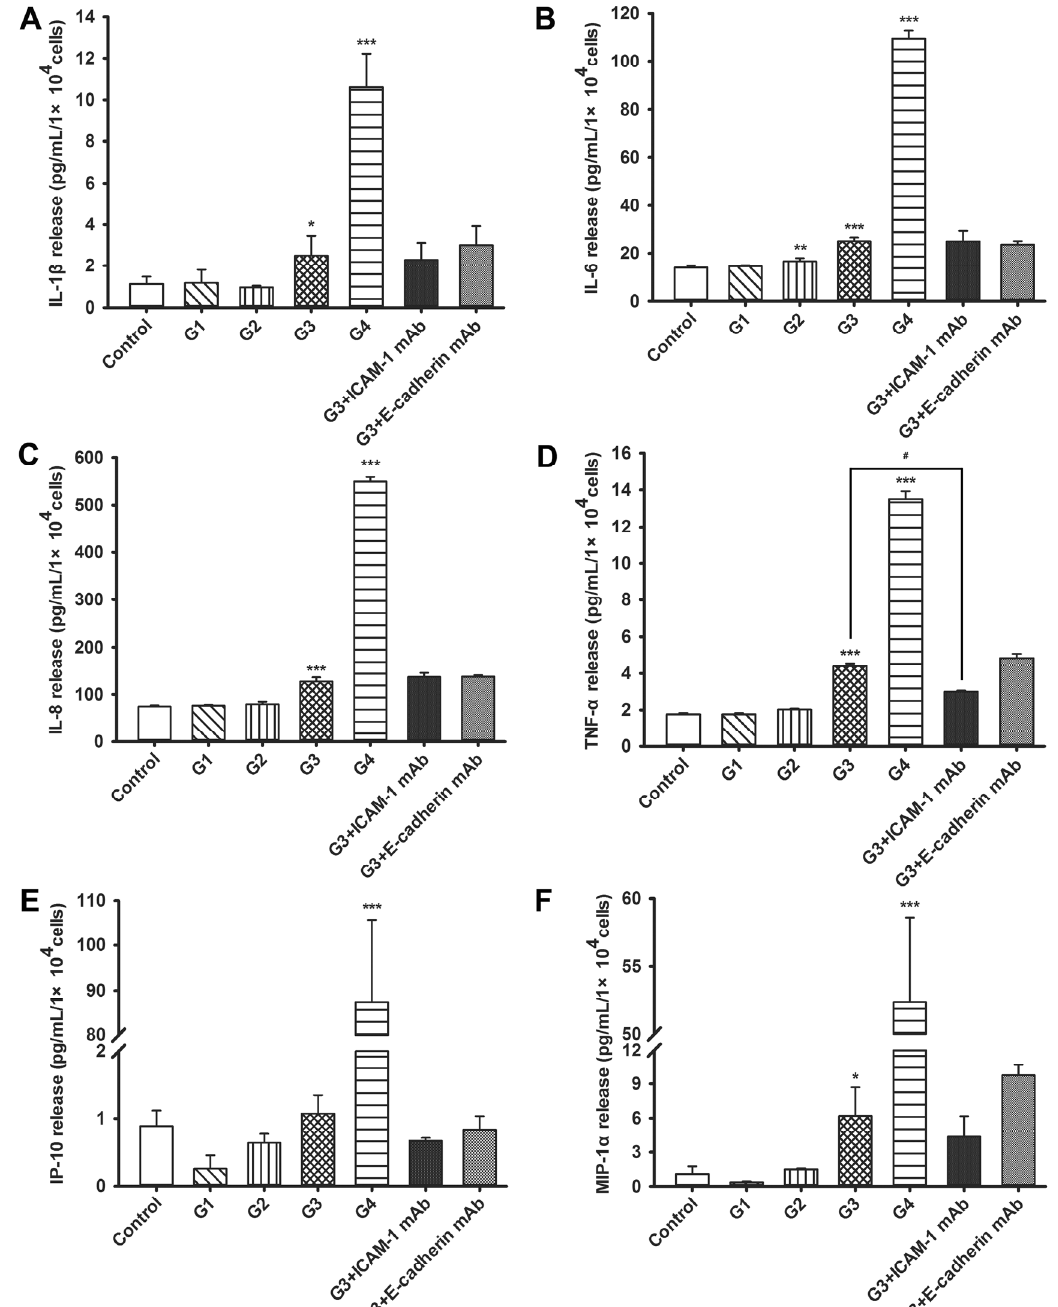
Figure 4. RSV-induced cytokine and chemokine secretion from 16HBE cells and the effect of ICAM-1 and E-cadherin neutralizing antibodies. The culture supernatants from the first to fourth generations (G1–G4) of RSV infection of 16HBE cells were analyzed for ( A ) interleukin (IL)-1 β ; ( B ) IL-6; ( C ) IL-8; ( D ) tumor necrosis factor- α (TNF- α ); ( E ) interferon- γ -induced protein-10 (IP-10); and ( F ) macrophage inflammatory protein-1 α (MIP-1 α ) concentrations using enzyme-linked immunosorbent assay (ELISA). Symbols signify statistical significance, where * p < 0.05, ** p < 0.01, and *** p < 0.001 compared with control (non-inoculated cells) and # p < 0.05 compared with the third generation (G3). G3 + ICAM-1 mAb group, G3 cells in which ICAM-1 was blocked; G3 + E-cadherin mAb, G3 cells in which E-cadherin was